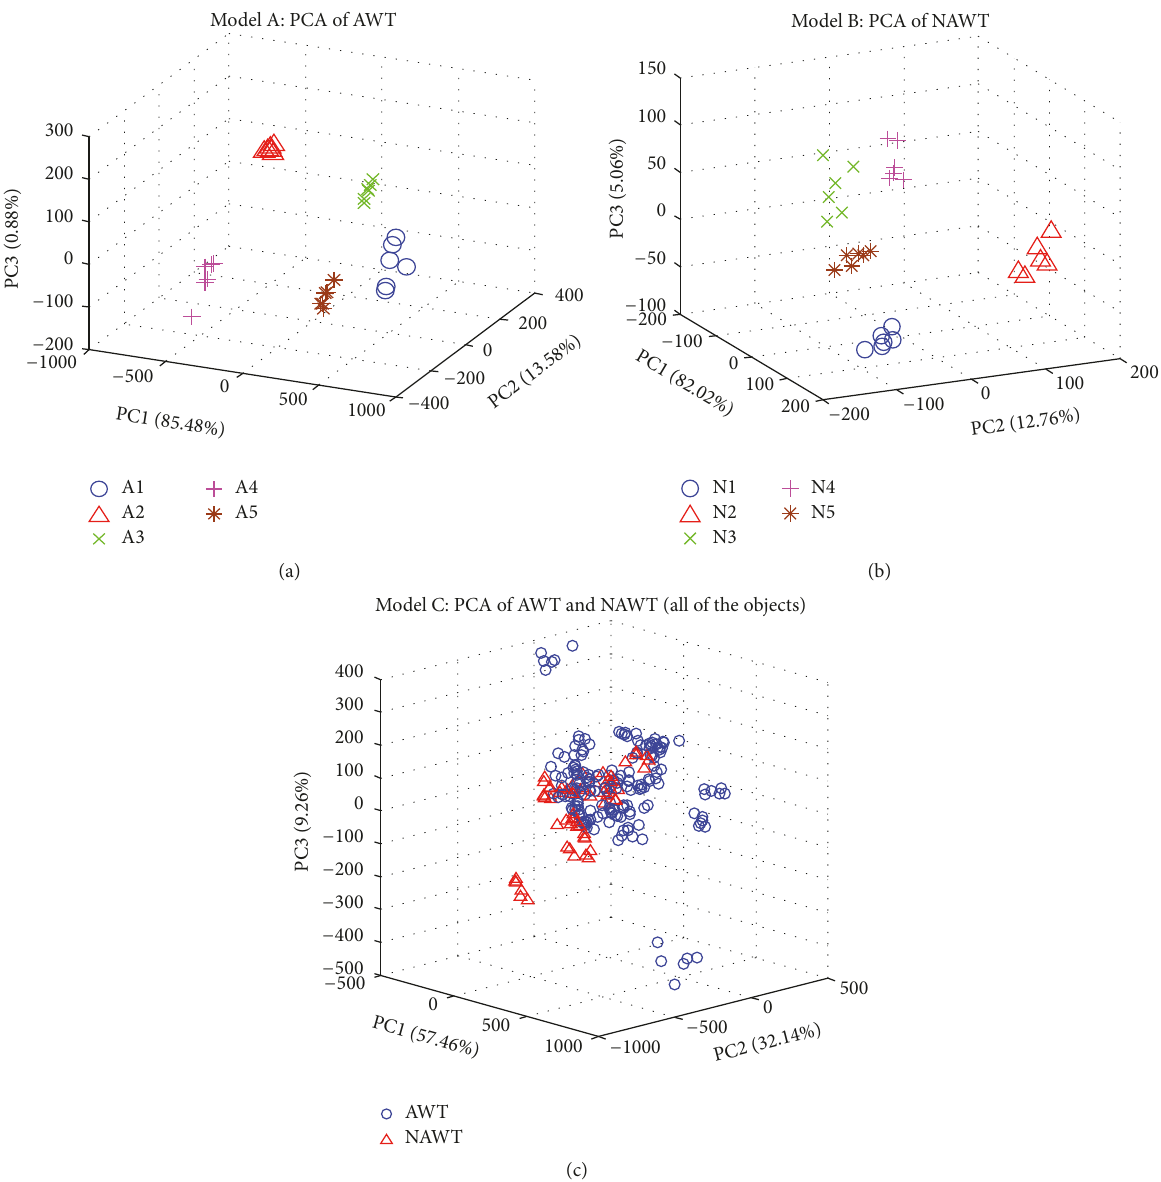
Figure 2: PCA scores of the samples in three-dimensional space formed by three principal components. The sample information is listed on the right; colors and marks are used for denotation.